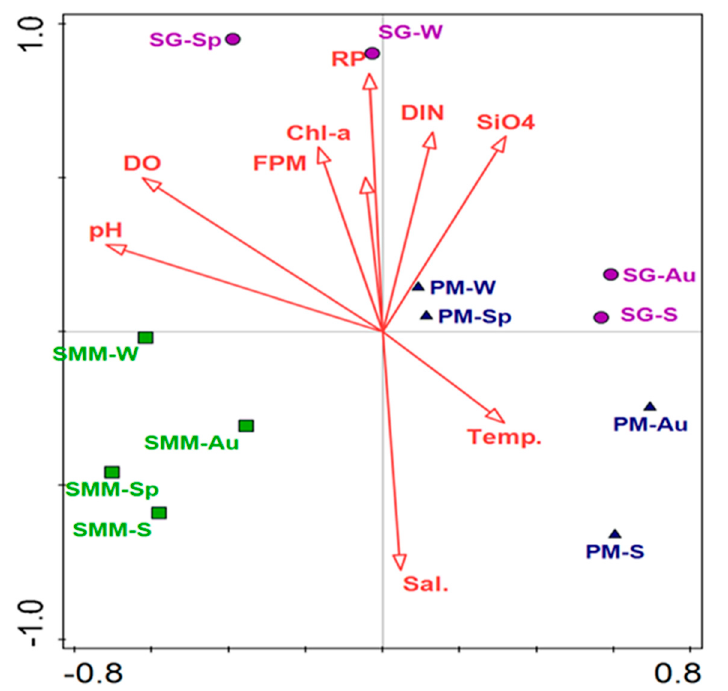
Figure 8. db-RDA analysis for U. laetevirens associated bacterial communities in response to environmental parameters. Sites: SMM = Santa Maria del Mare, PM = Porto Marghera, and SG = San Giuliano; seasons: Sp = spring, S = summer, Au = autumn, W = winter; environmental parameters: DO = dissolved oxygen, FPM = filtered particulate matter, Chl -a = chlorophyll -a , RP = reactive phosphorus; DIN = dissolved inorganic nitrogen, SiO 4 = silicates; Temp. = temperature, Sal. = salinity.